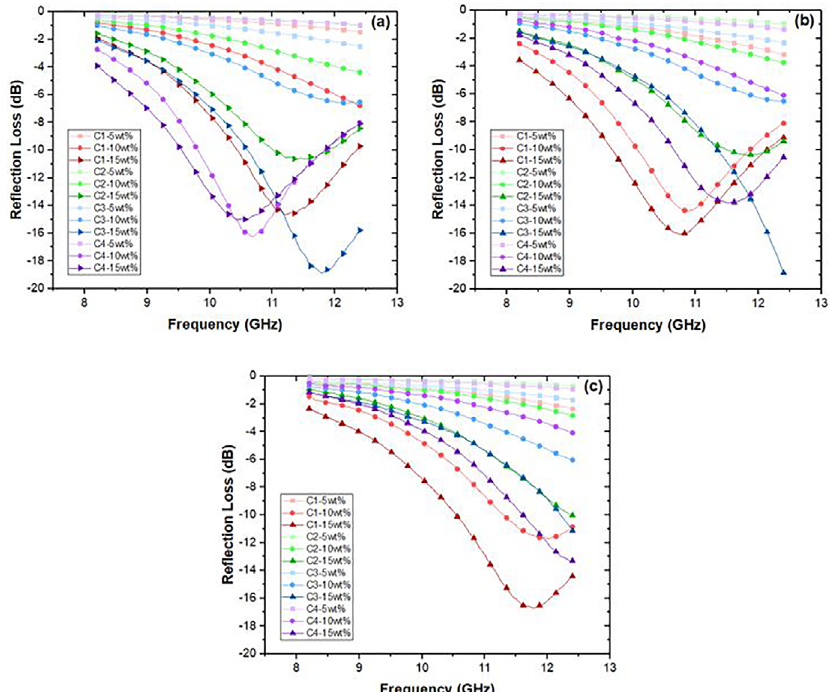
Figure 6. RL of DUT a) without FSS, b) with FSS of 2.0 mm diameter holes and c) with FSS of 5.0 mm diameter